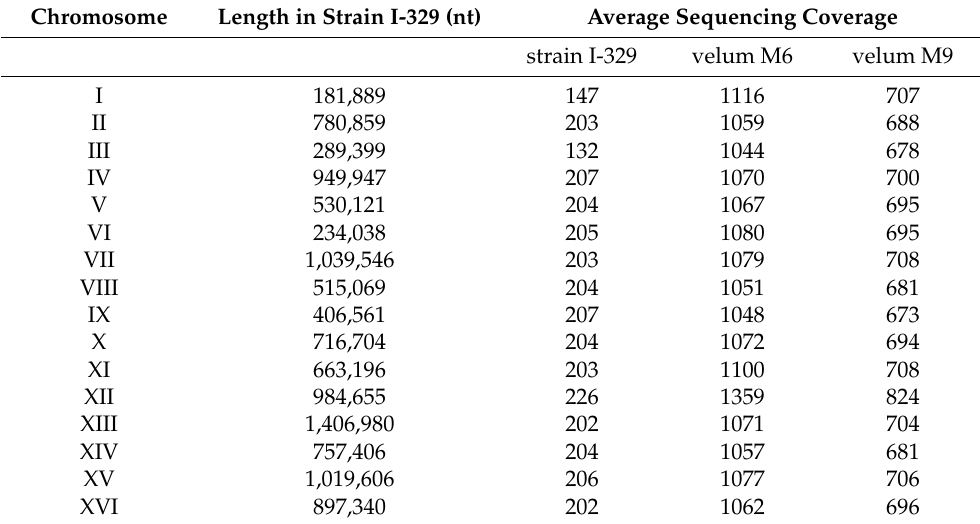
Table 3. Strain I-329 genome: chromosome sizes and average sequencing coverage.